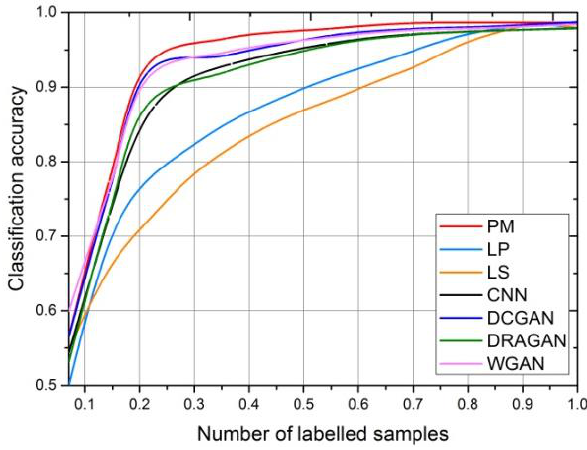
Figure 10. The average recognition accuracy of MCGAN, supervised CNN, DCGAN, DRAGAN, LS, LP, and WGAN-GP trained using different numbers of labeled images (64×64).